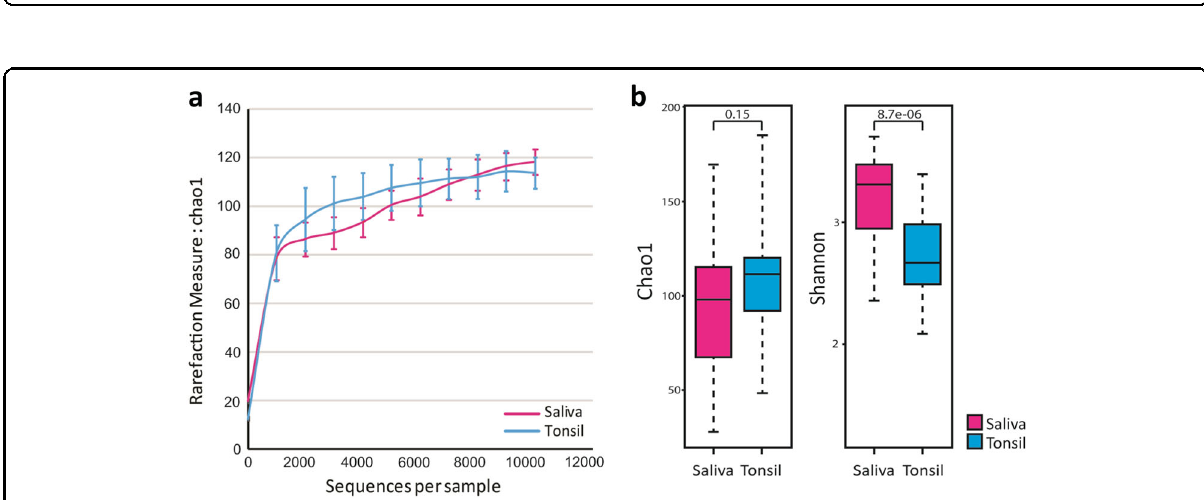
Fig. 2 Comparison of alpha diversity between saliva and tonsils. a Rarefaction measured based on the Chao1 index and b box plots for alpha diversity based on the Chao1 and Shannon indices. Magenta represents saliva, and blue signi fi es tonsillar